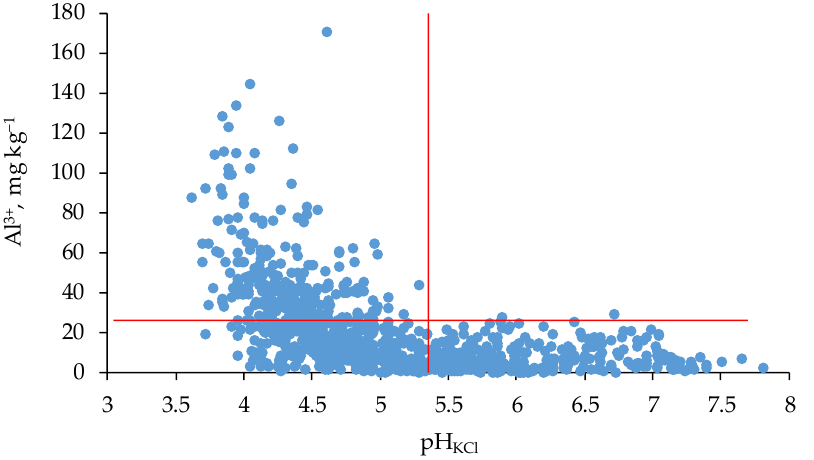
Figure 12. Exchangeable aluminum (Al 3+ ) content as a function of soil pH measured in suspension of 1 molar KCl (1:2.5, w / v ). Sandy soils, western Poland ( n = 986). The red lines indicate the critical points for soil pH and Al 3+ content. Source: Błaszyk [146]